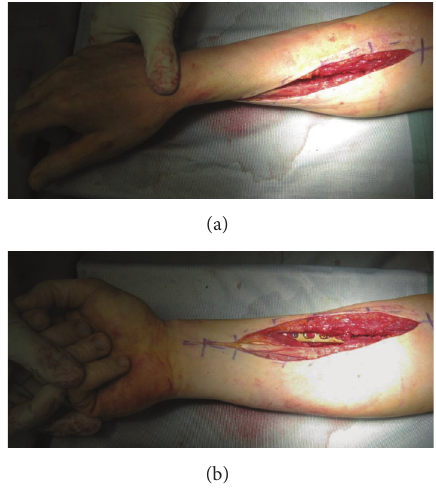
Figure 4: The pronosupination was complete immediately after excision and tested intraoperatively.